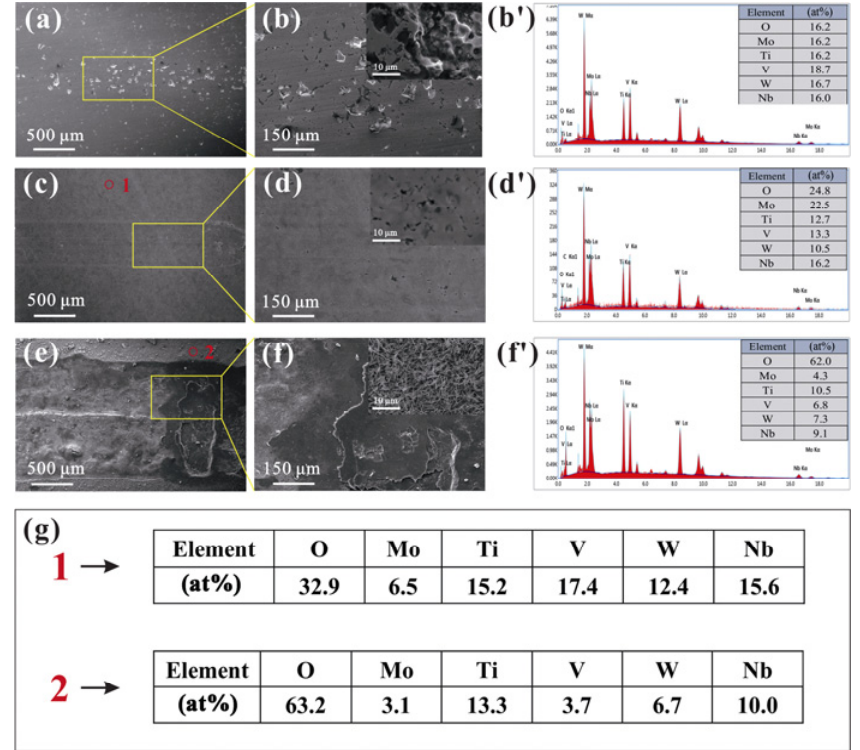
Fig. 12 SEM micrographs of worn surfaces of high-entropy (TiVNbMoW)C 4.375 at (a, b) RT, (c, d) 400 ℃ , and (e, f) 800 ℃ ; (b’, d’, f’) corresponding EDS spectra from (b, d, f); (g) atomic percentages of point 1 and point